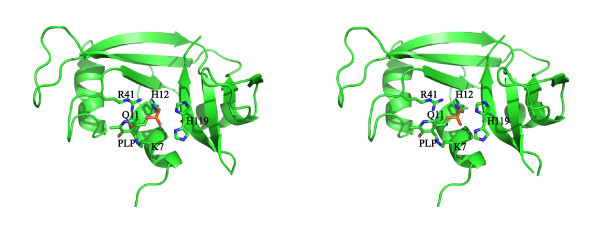
Stereo cartoon representation of RNase(K41R)-PLP. The cofactor and selected binding residues appear in stick mode, in green and atom colors. His119 is shown in two alternative conformations, which are also seen in the template structure [24].